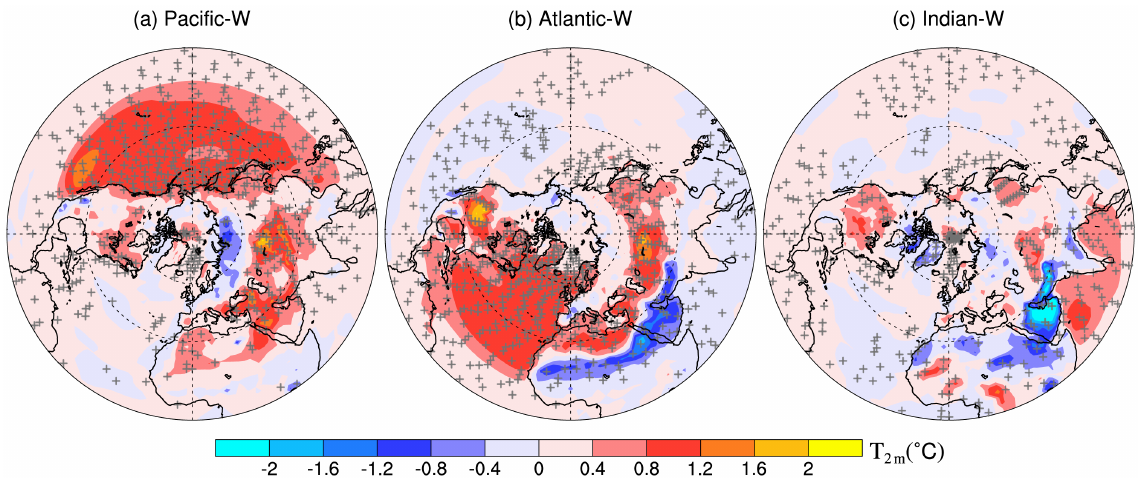
Figure 4. Changes in the surface air temperature ( ◦ C) for (a) Pacific-W, (b) Atlantic-W, and (c) Indian-W relative to CTRL in the Northern Hemisphere in the boreal summer. The + symbols denote areas in which the results are significant at the 0.05 level, evaluated using the Student’s t test and 20 years of